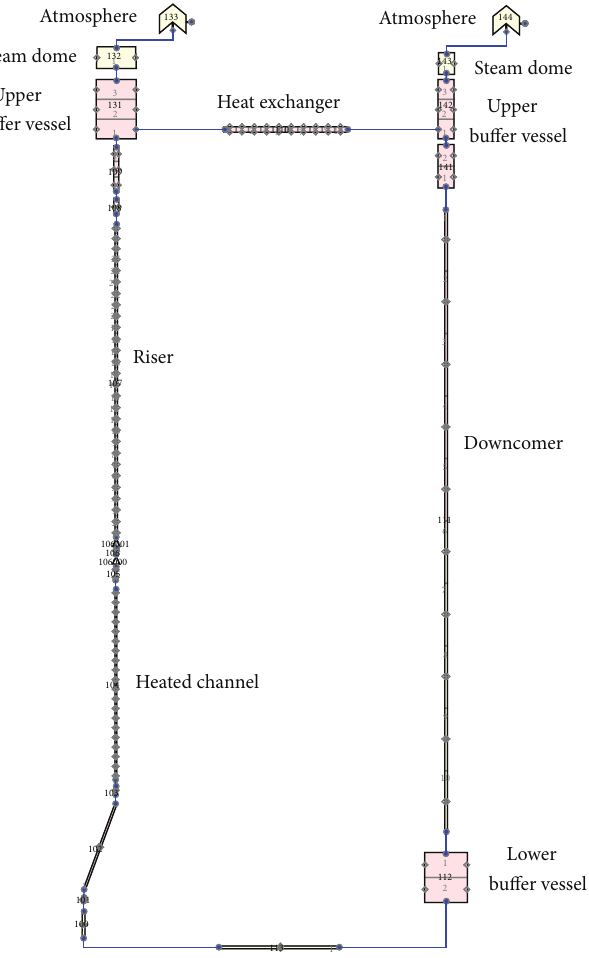
Figure 4: RELAP5 and TRACE nodalization of the CIRCUS-IV single channel